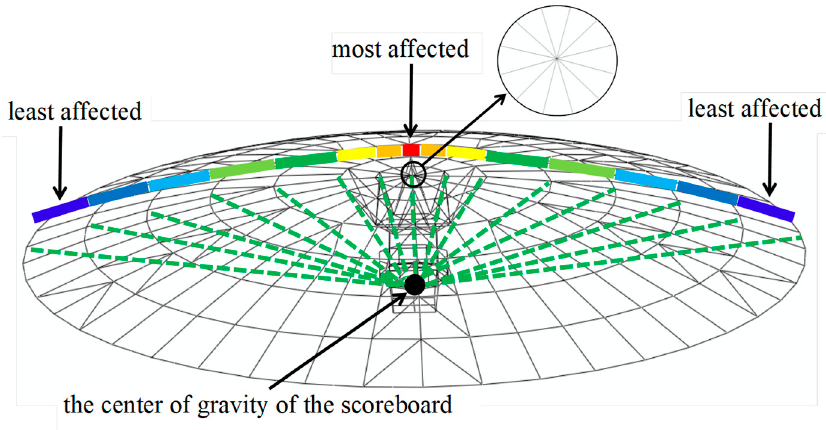
Figure 19. The influence of the scoreboard on different positions of the suspen-dome